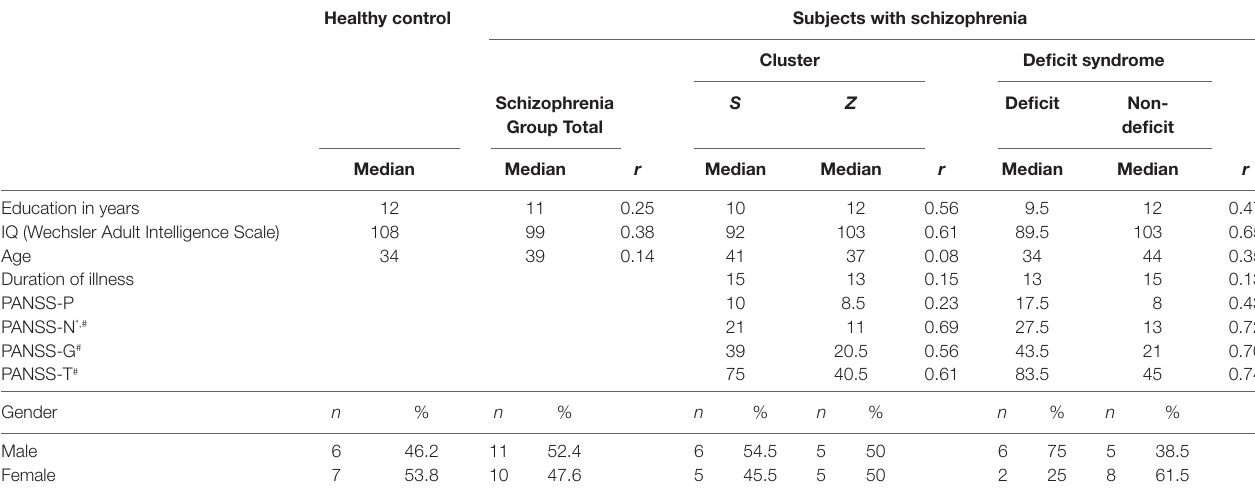
TaBle 1 | Demographic and clinical characteristics of the study